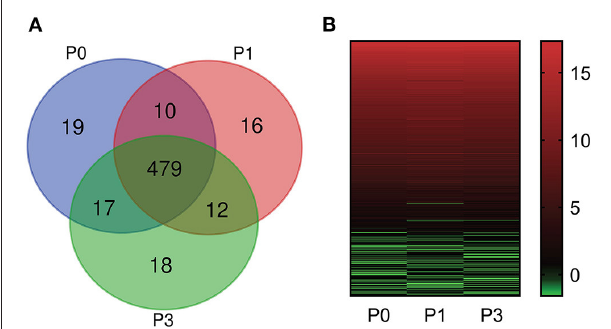
FIGURE 2 | miRNA expression profiles. (A) Comparison of miRNA expression in lung of New Zealand Rabbits at different times post induction (Venn diagram). P0, P1, and P3 in the figure represent the groups 0 dpi, 1 dpi, and 3 dpi. (B) Heat map is based on the expression of miRNAs FPKM-based data from rabbit lung at 1 dpi and 3 dpi with P. multocida , compared to unchallenged controls (0 dpi); and drawn with GraPhpad Prism 8 software. Red indicates higher relative expression and green indicates lower relative expression.